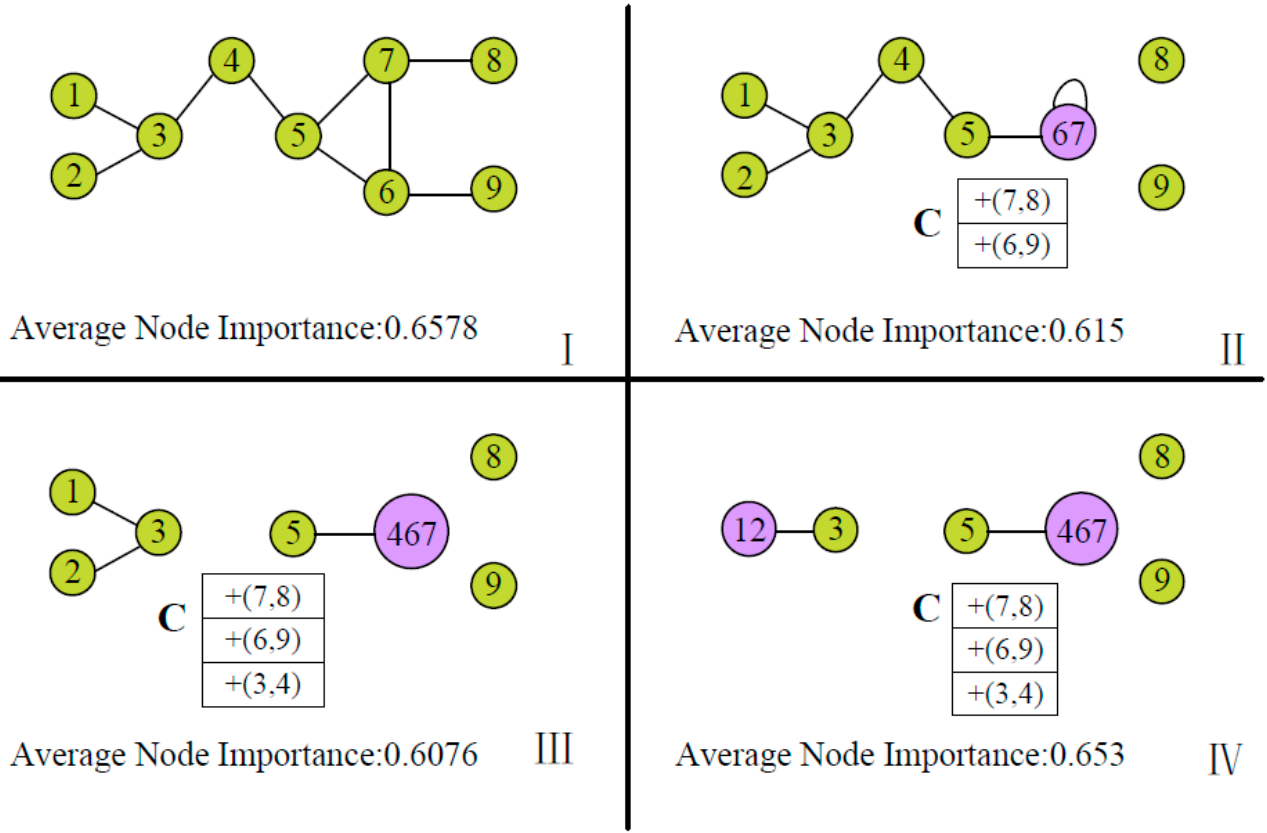
Figure 1. Average node importance example in random summarization.